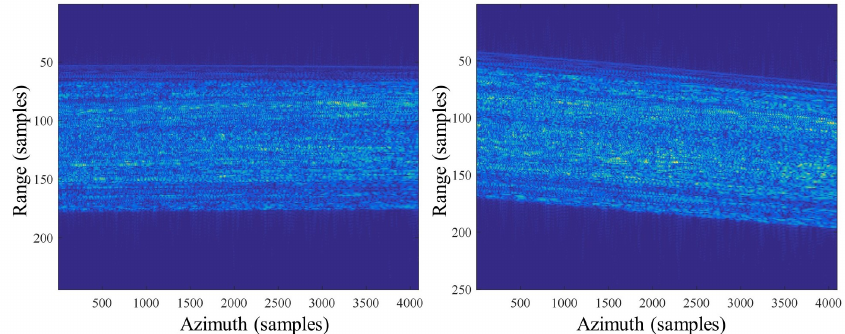
Figure 13. Determination result of ship target radial velocity.